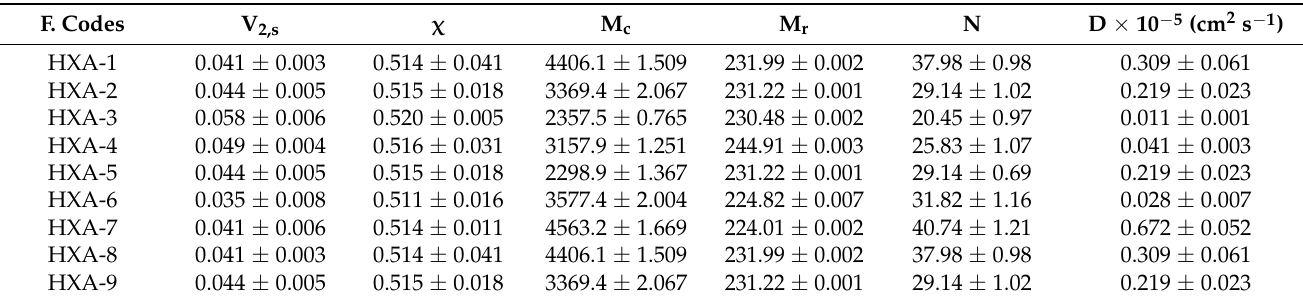
Table 4. Flory–Huggins network parameters of xanthan gum-based (HPMC- g -AMPS) hydrogels (data are presented as mean ± standard deviation, n =